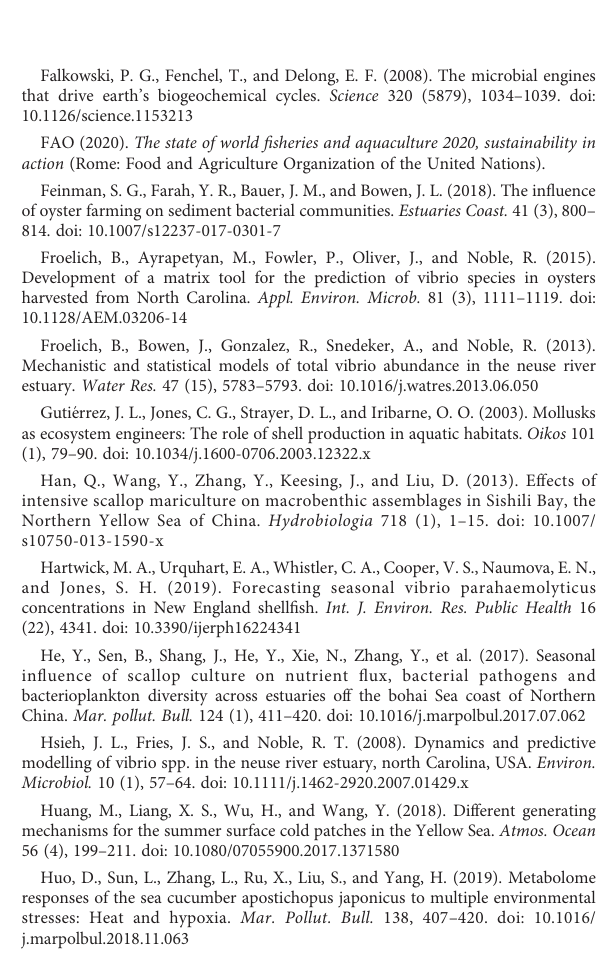
The prediction accuracy of ANN model for Vibrio abundance for both training samples and testing